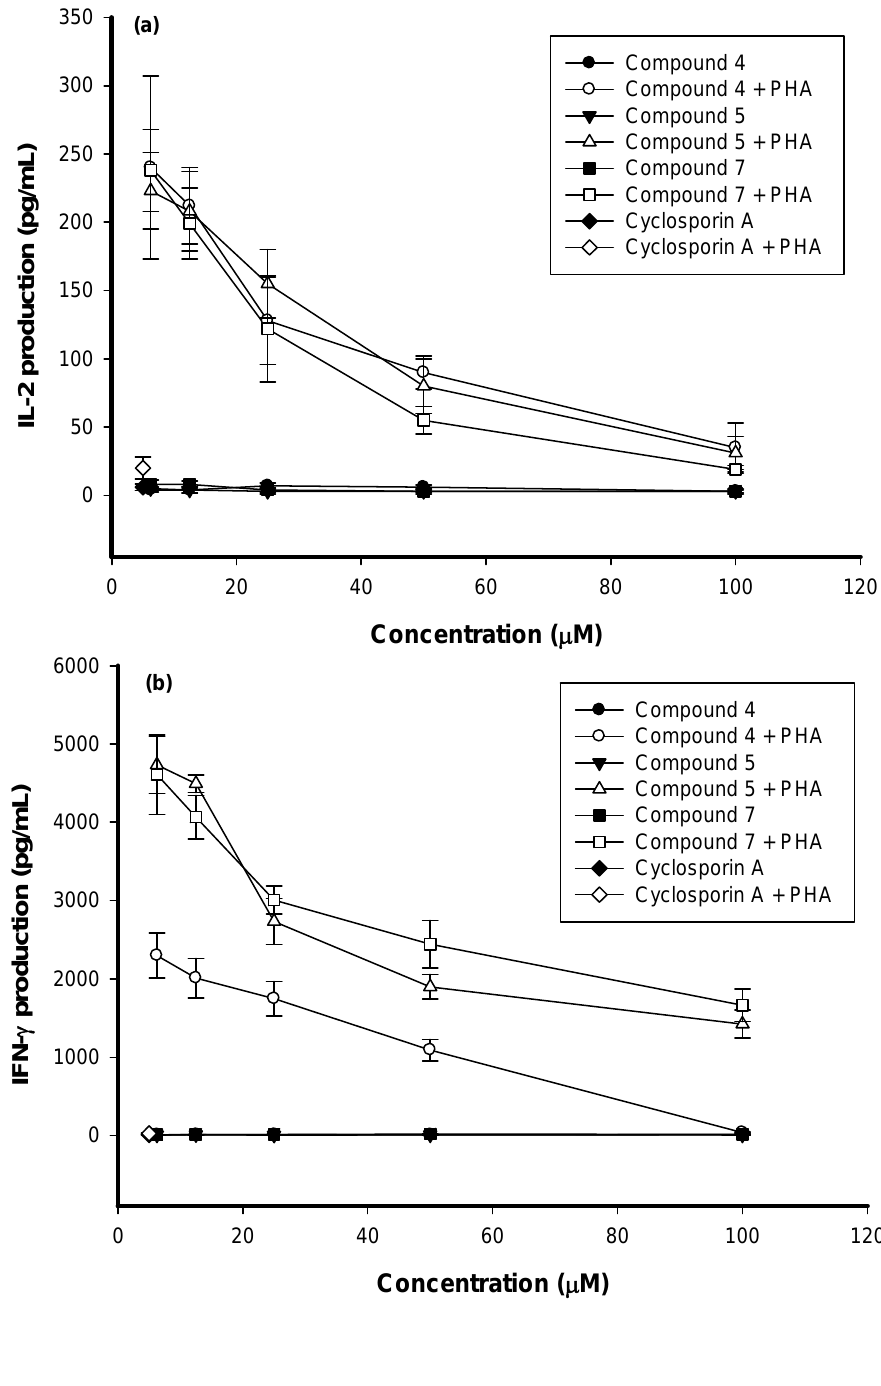
Figure 2. The impairment of IL-2 and IFN- γ production in PBMC treated with compounds 4 , 5 , and 7 . PBMC (2×10 5 cell/well) were treated with 6.25, 12.5, 25, 50, and 100 µM of compounds 4, 5, and 7 with or without PHA (5 µg/mL) for 3 days. Cyclosporin A (5 µM) was used as positive control. Then, the cell supematants were collected and IL-2 (a) and IFN- γ (b) concentration were determined by EIA. Each of the point is the mean ± SD of three independent